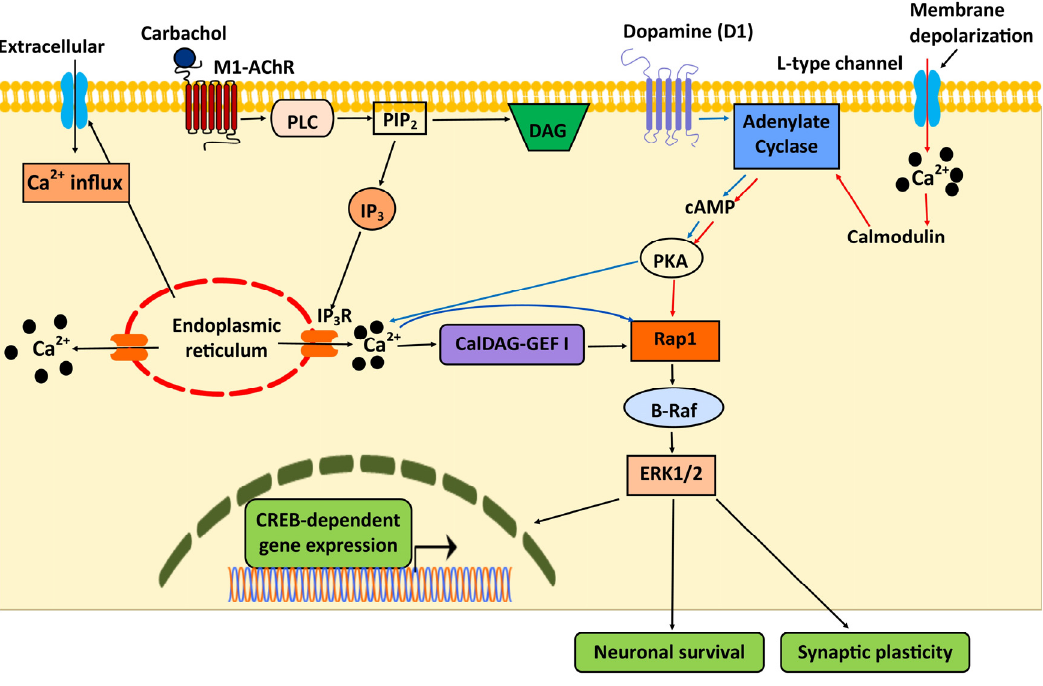
Figure 1. Rap1 and Ca 2 + signaling in the central nervous system (CNS). Rap1 / B-Raf / ERK is the main pathway controlling synaptic plasticity, gene expression and neuronal survival, and is induced by Ca 2 + signal upstream from Rap1 activation. Muscarinic acetylcholine receptor (M1-AChR)-induced Ca 2 + release and extracellular Ca 2 + influx activate Rap1 via CalDAG-GEFI. Dopamine (D1)-induced cAMP / PKA activation followed by Ca 2 + release from intracellular stores (blue arrows), results in CREB phosphorylation and gene expression. Membrane depolarization and Ca 2 + influx via L-type Ca 2 + channels activates cAMP / PKA / Rap1 / B-Raf via calmodulin (red arrows), modulating synaptic plasticity and neuronal survival.